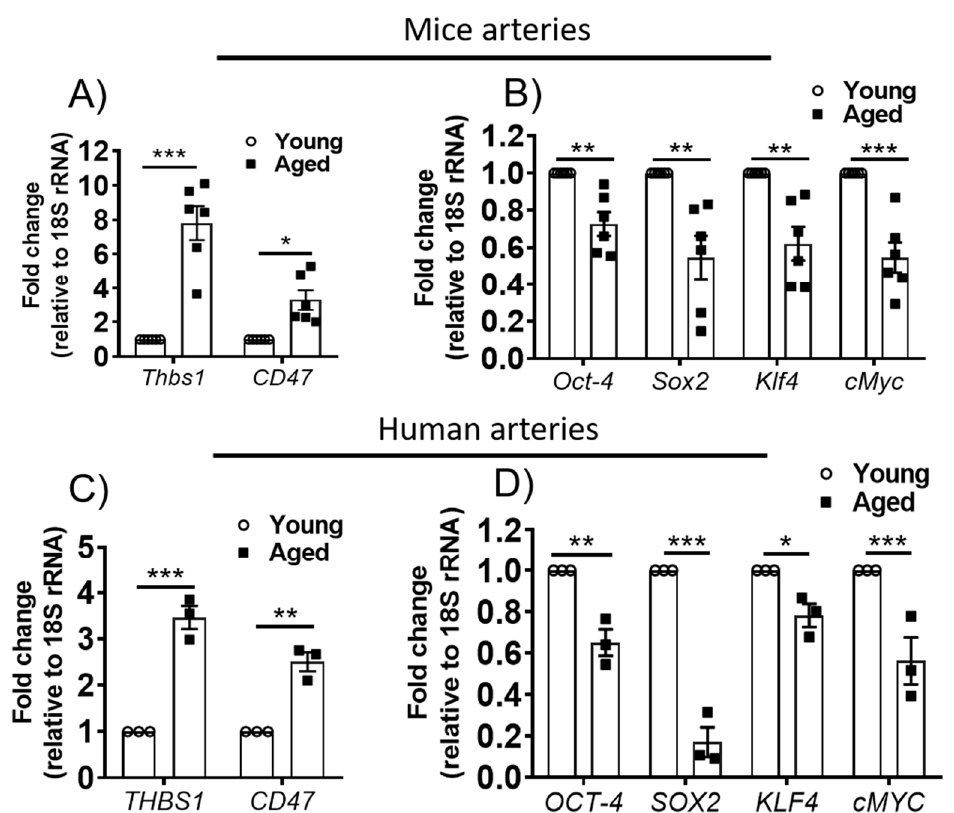
Figure 1. TSP1 and CD47 are increased and self-renewal transcription factors decreased in arteries from aged animals and older individuals. Gene expression profiling by q-PCR of Thbs1 and Cd47 ( A ) and self-renewal factors OCT4, SOX2, KLF4 and cMYC ( B ) in aortas from young (3-month-old) and aged (18-month-old) mice and in distal 5 th -order mesenteric arteries from young ( < 33 years) and old ( > 60 years) healthy human subjects ( C , D ). Error bars represent the mean ± SEM, samples in triplicate / mouse, 3–5 mice / group. Samples in triplicate / individual, 3 subjects / group. Data normalized to the 18srRNA gene. An unpaired t -test was performed with * p < 0.05, ** p < 0.01, *** p < 001.